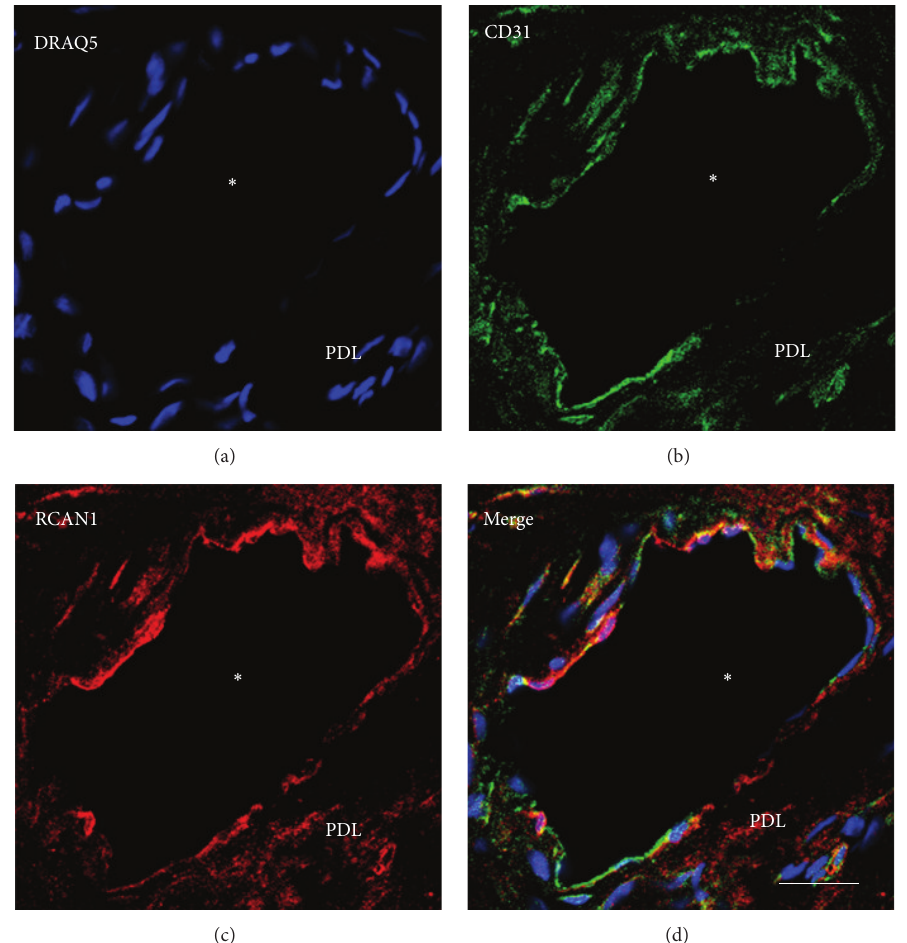
Figure 2: Confocal microscopy and immunofluorescence of RCAN1 in PDL. Cell nuclei of the PDL cells were identified by DRAQ5 (a; blue). The colocalization of CD31 (b: green; a marker for endothelial cells) and RCAN1 (c; red) in blood vessel walls of healthy PDL indicates that RCAN1 is localized in blood vessel endothelia. ∗ = lumen of blood vessel (d; merge; yellow); white bar = 20 𝜇 m.